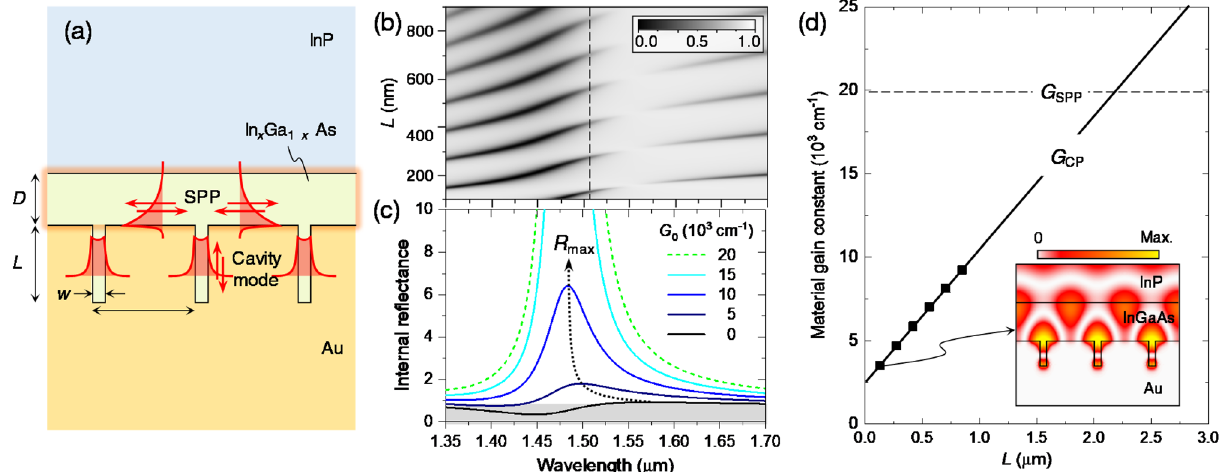
Figure 4. Plasmonic inverse-cavity laser property. ( a ) Structure geometry of an Au-InGaAs-based plasmonic inverse-cavity structure where periodic nanoslits function as plasmonic nanocavities and resonant grating for SPPs on the Au-InGaAs interface. ( b ) Reflectance spectrum on L - λ plane for a plasmonic inverse-cavity structure under normal incidence from the InP cover. Geometrical parameters Λ = 410 nm, w = 50 nm, D = 200 nm. We take frequency-dispersive optical constants of InP 25 , InGaAs 26 , and Au 27 from the literature in consideration of relatively wide spectral range of the plasmonic resonance effects in our present case. ( c ) Amplified internal reflectance spectra due to a gain-assisted SPP resonance for increasing G 0 . ( d )